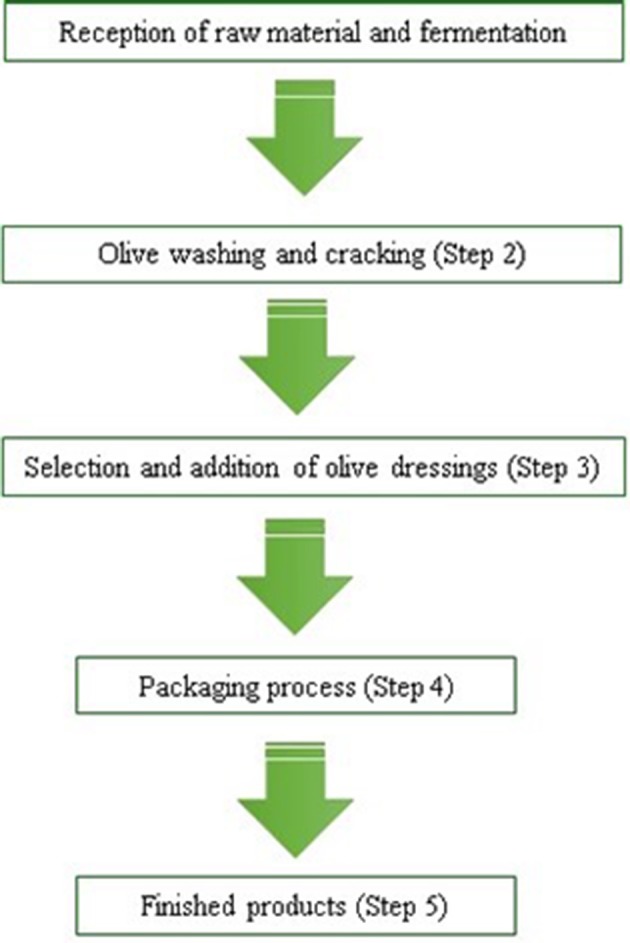
Flow diagram of the elaboration process of Aloreña table olives shared by the different industries visited in the study.